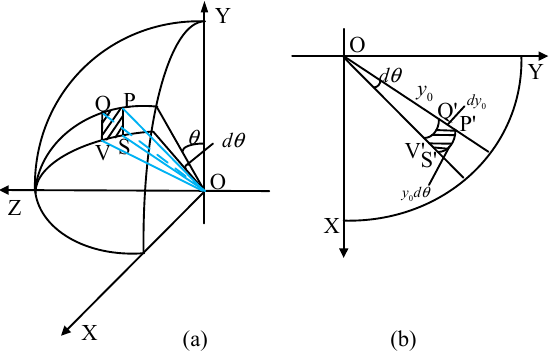
Figure 8. Correspondence between a tiny bin PQVS in the skylight polarization pattern and P (cid:48) Q (cid:48) V (cid:48) S (cid:48) on the imaging plane, where light is incident from the Z -axis and imaged on the plane XOY after passing through the imaging system. ( a ) The three-dimensional coordinate representation of skylight polarization pattern; ( b ) the imaging relationship of skylight polarization pattern.